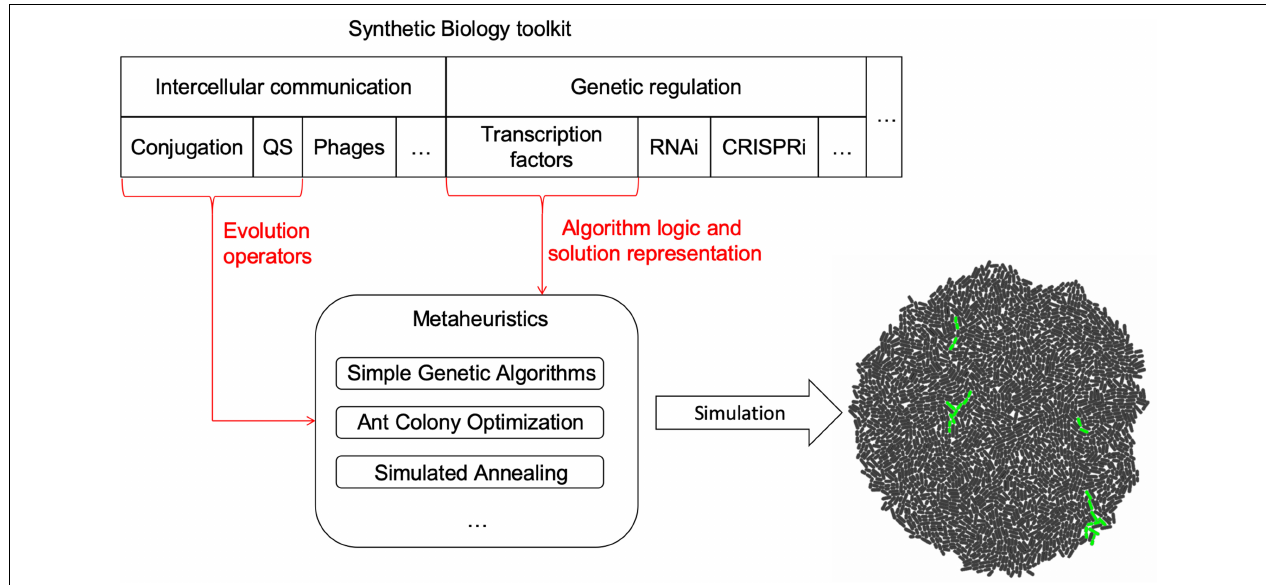
FIGURE 1 | Framework components. Intercellular communication processes were chosen as the tools to implement evolution operators in MH for cell colonies. Depending on what MH is implemented, each process could play a different role. MH logic and representation are encoded using transcriptional regulation. However, other possibilities such as the use of RNA or CRISPR mediated regulation remain open to be explored as new forms of logic and representation for MH. The selected tools are then mapped to the logic of the specific MH, generating a model. Once the model and mapping have occurred, a gro simulation file is outputted and run to collect data on the behavior of the